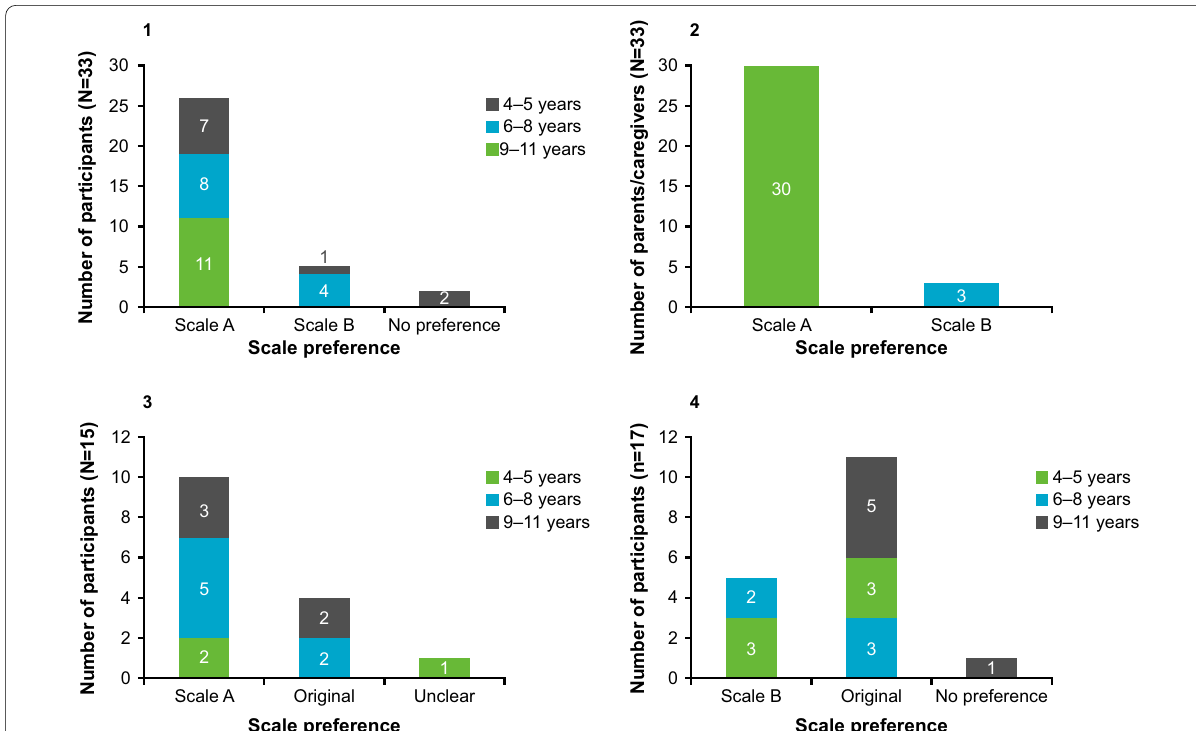
Fig. 7 Comparison of scales. 1 Participant preference (modified scale A vs scale B); 2 Parent/caregiver preference (modified scale A vs scale B); 3 Participant preference (modified scale A vs original C‑ACT); 4 Participant preference (scale B vs original C‑ACT). C‑ACT, CHILDHOOD ASTHMA CONTROL